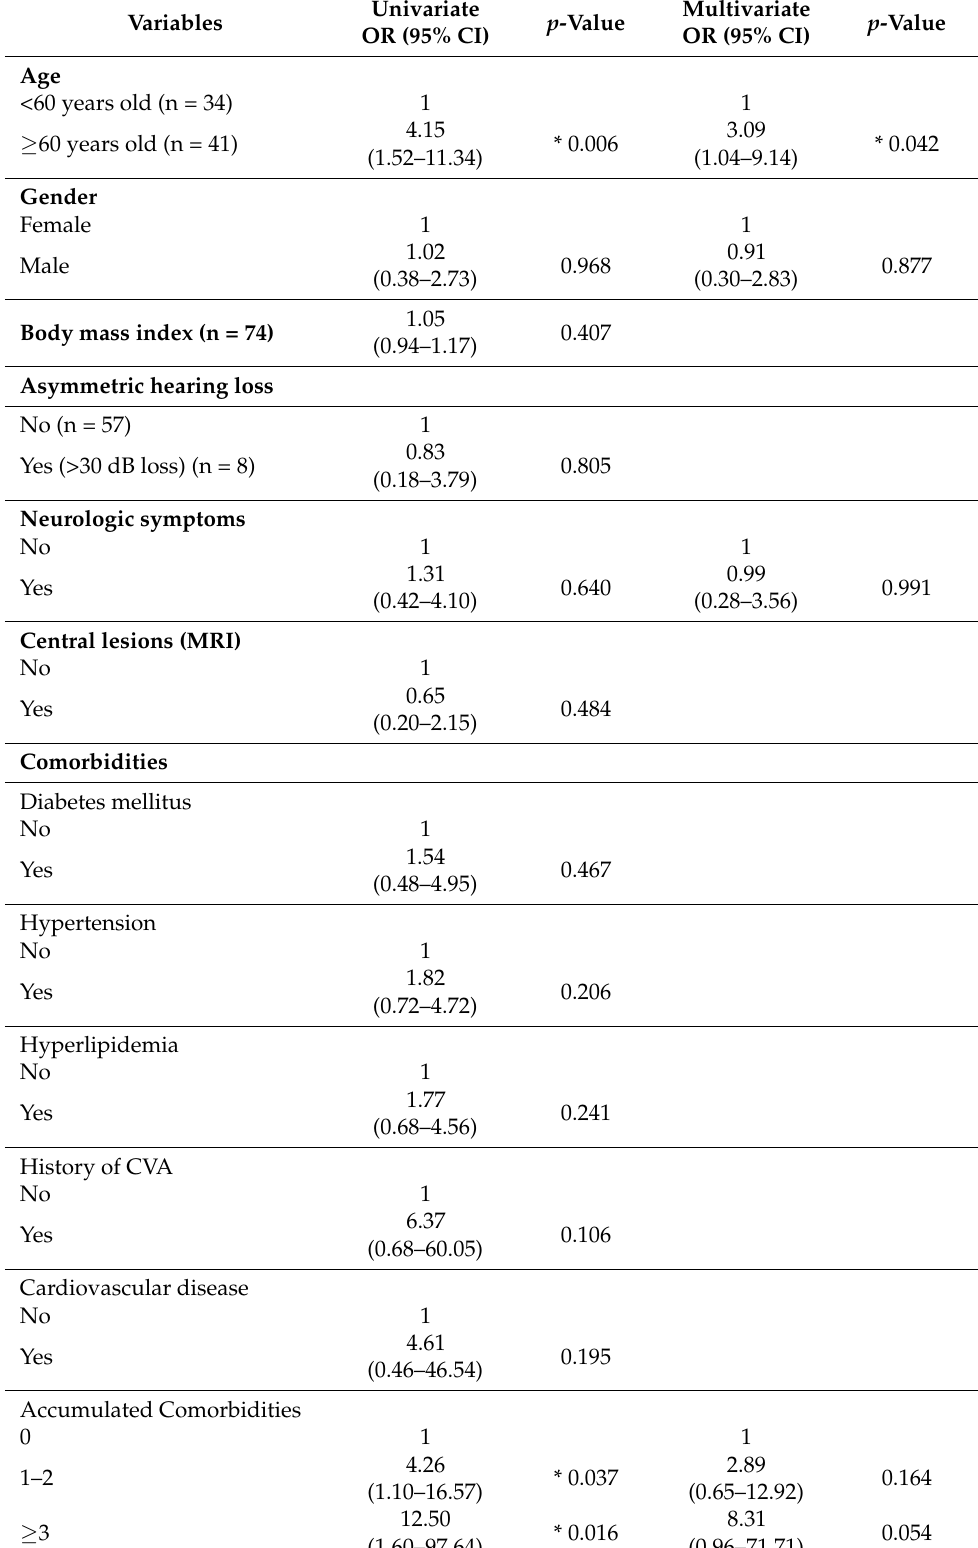
Table 4. Univariate and multivariate analyses of factors predicting discordance between the interpre- tations of oculomotor tests and brain MRI ( n =